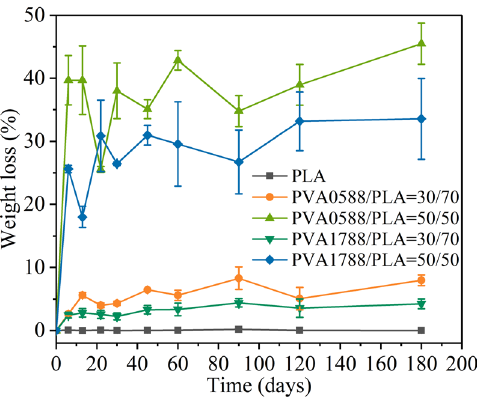
Figure 6: GPC curves of pure PLA before degradation, pure PLA and PLA in blends after natural seawater degradation for 180